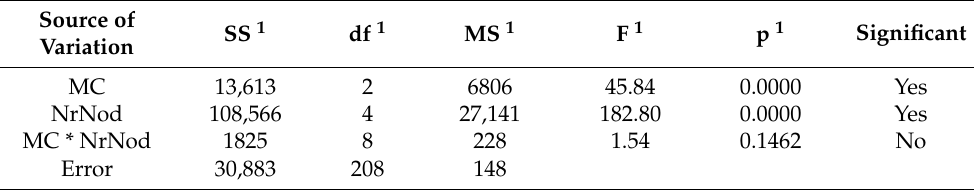
Table 8. Two-way ANOVA results for maximum stress in bending ( σ bend ).